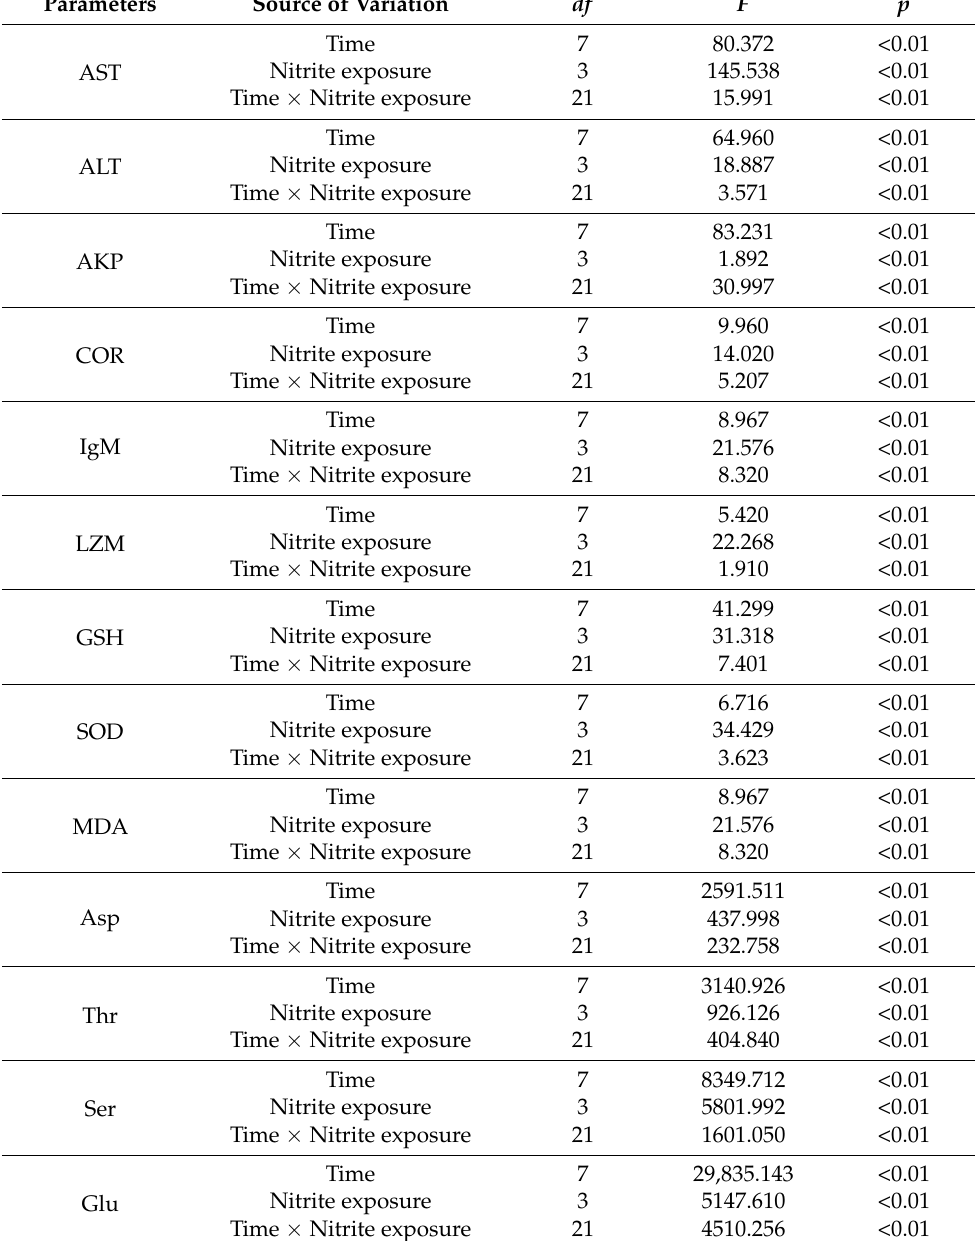
Table 1. The results of the interaction between time and/or nitrite exposure on FAAs, blood biochem- ical parameter levels, oxidative stress, and immune-related markers are shown